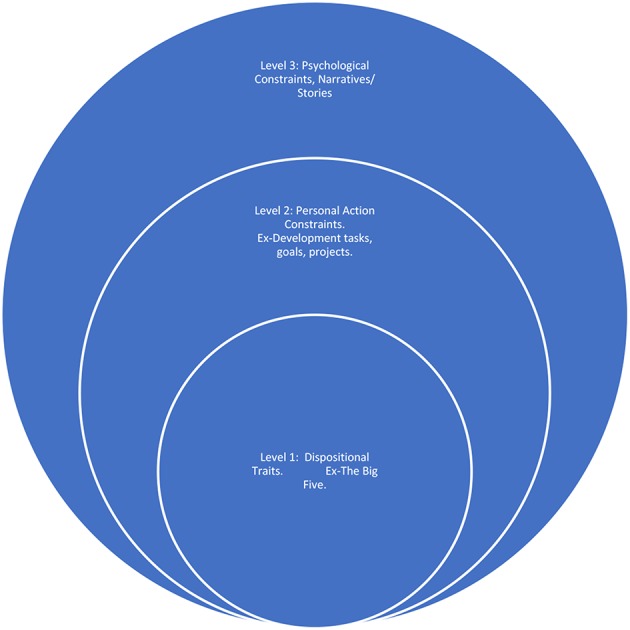
Mcadams identity multi-layer model (McAdams, 2009).